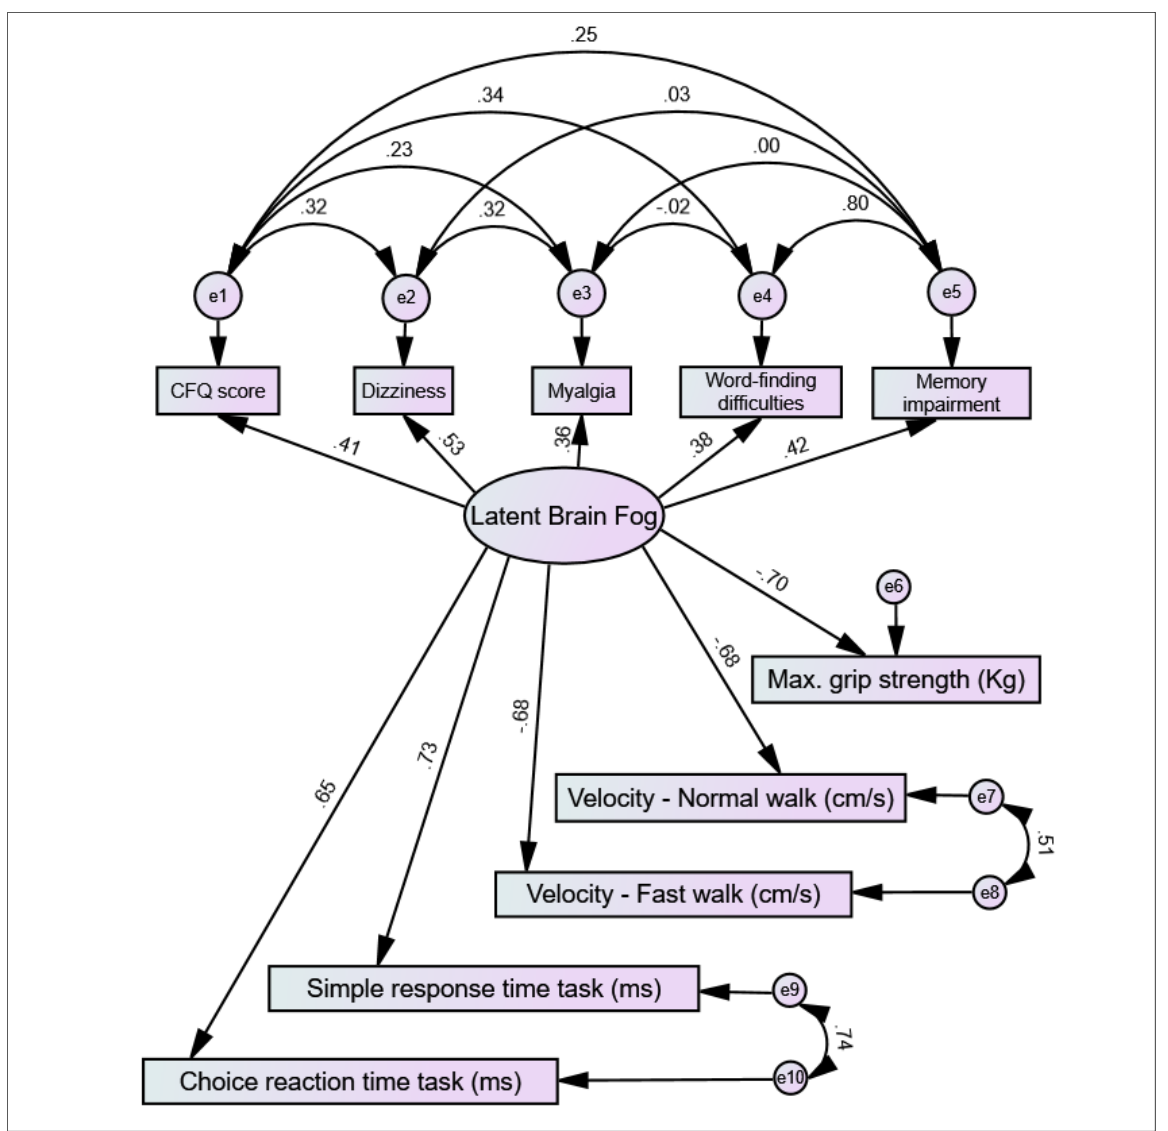
Figure 1. Results of the structural equation model hypothesising symptomatic indicators and psy- chomotor effects of brain fog as a latent variable. CFQ: Chalder Fatigue Scale score. The model was supported by the data ( χ 2 = 21.49, df = 24, p = 0.609). e1, e2, e3, etc.: error terms for measured variables.